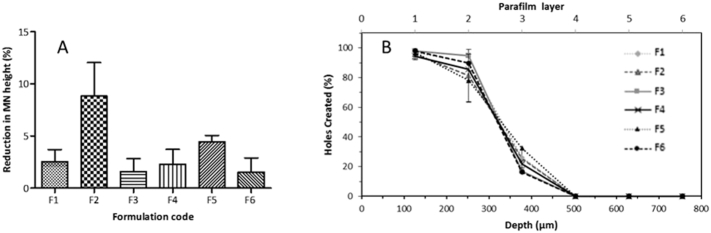
(A) Comparison of percentage of MN height reduction of dissolving MN formulations tested, observed following the application of a force of 32 N/array (means + S.D., n = 4). (B) Percentage of holes created in each Parafilm M® layer following insertion of dissolving MN formulations investigated. MN arrays used were 19 × 19 with a needle height of 500 μm, base width of 300 μm and a base interspacing of 50 μm (means + S.D., n = 4).